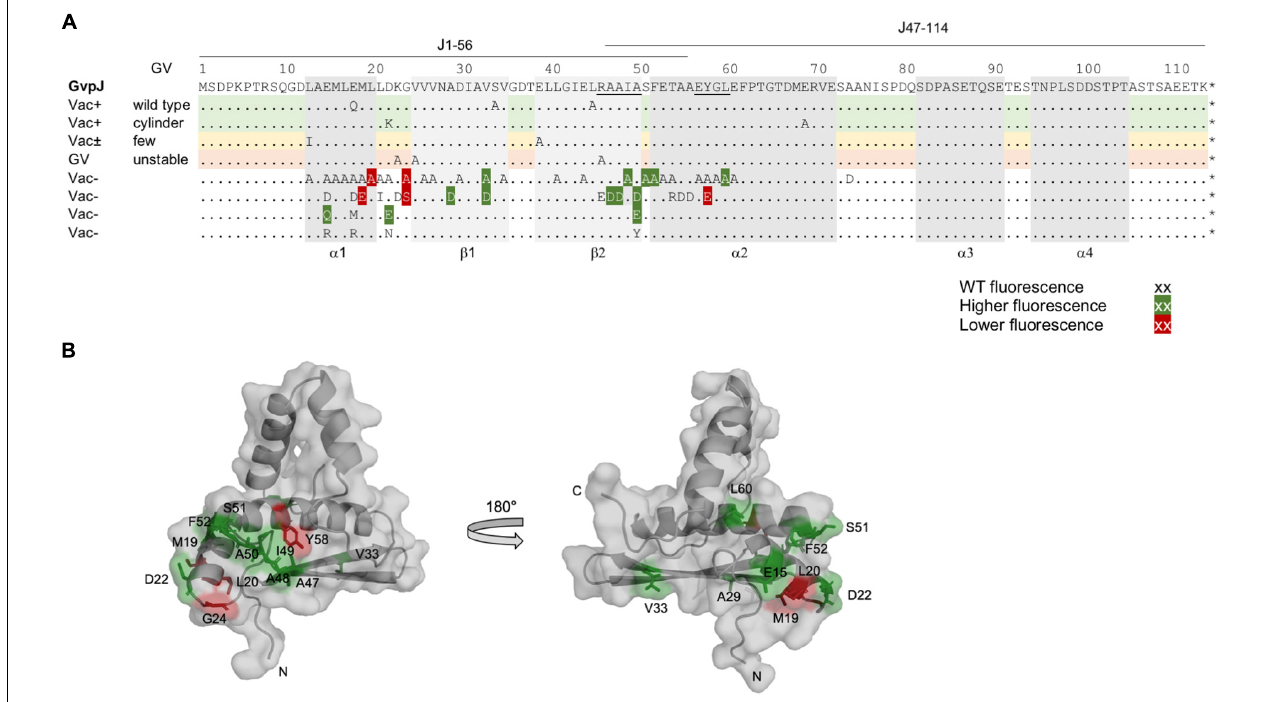
FIGURE 4 | Summary of the fluorescence of L/J mut transformants in relation to the Vac phenotype of the respective (cid:49) J + J mut transformants. (A) Amino acid sequence of GvpJ; the α -helices and β -sheets are shaded in gray. These structural features are marked at the bottom of the alignment. The RAAIA and EYGL motifs are underlined. The lines on top indicate the aa sequence present in fragments J1–56 and J47–116. A summary of the single aa substitutions resulting in a Vac + , Vac ± , or Vac − phenotype is given below. Dots represent aa identical to GvpJ, and each letter represents a single aa substitution in J mut . Substitutions yielding a significantly higher fluorescence in L/J mut transformants are shaded in dark green, whereas a lower fluorescence is shaded in red. (B) Homology structural model of GvpJ and location of the aa leading to a higher (green) or a lower (red) fluorescence. The homology model of GvpJ is based on the in silico model of GvpA (Strunk et al., 2011) and was calculated by the I-Tasser server (Zhang, 2008; Roy et al., 2010; Yang et al.,